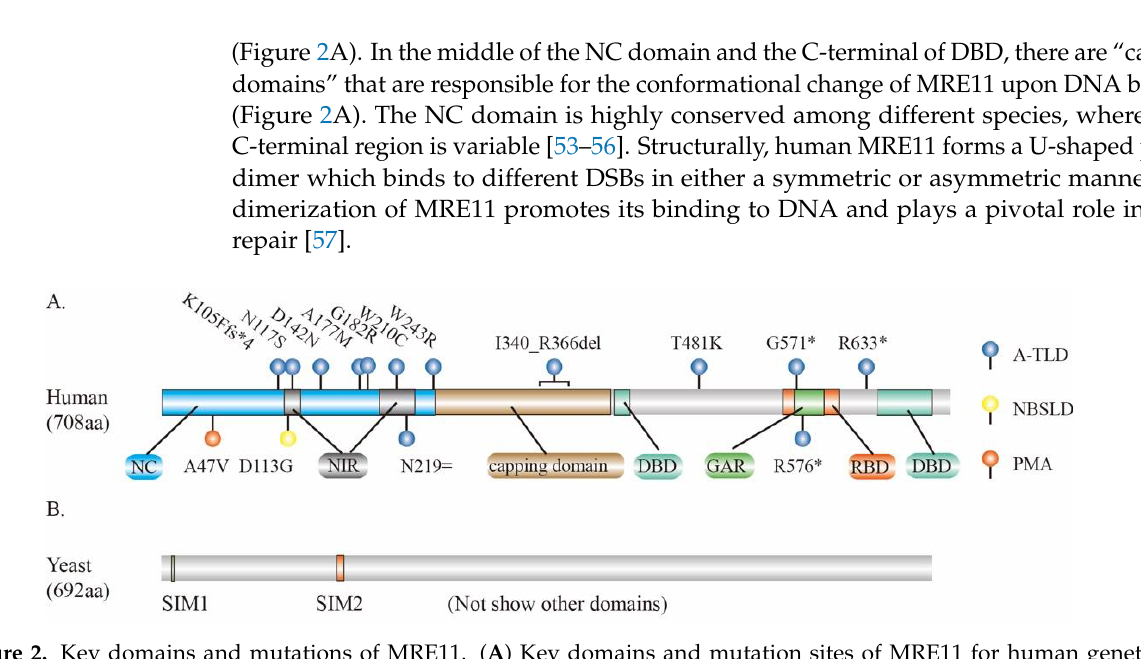
Figure 2. Key domains and mutations of MRE11. ( A ) Key domains and mutation sites of MRE11 for human genetic diseases. ( B ) Two SUMO-interacting motifs (SIM1 and SIM2) within MRE11 of S. cerevisiae that preferentially interact with the poly-SUMO chain. PMA, progressive myoclonic ataxia; NBSLD, Nijmegen breakage syndrome-like disease; A-TLD, ataxia-telangiectasia-like disorder; NC, nuclease core; DBD, DNA binding domains; GAR, glycine- and arginine-rich region; NIR, NBS1 interacting region; RBD, RAD50 binding domain; del, deletion; asterisk (*) means stop codon; equal sign (=) means synonymous mutation; fs*4 means stop codon is the 4th amino acid following frameshift mutation.